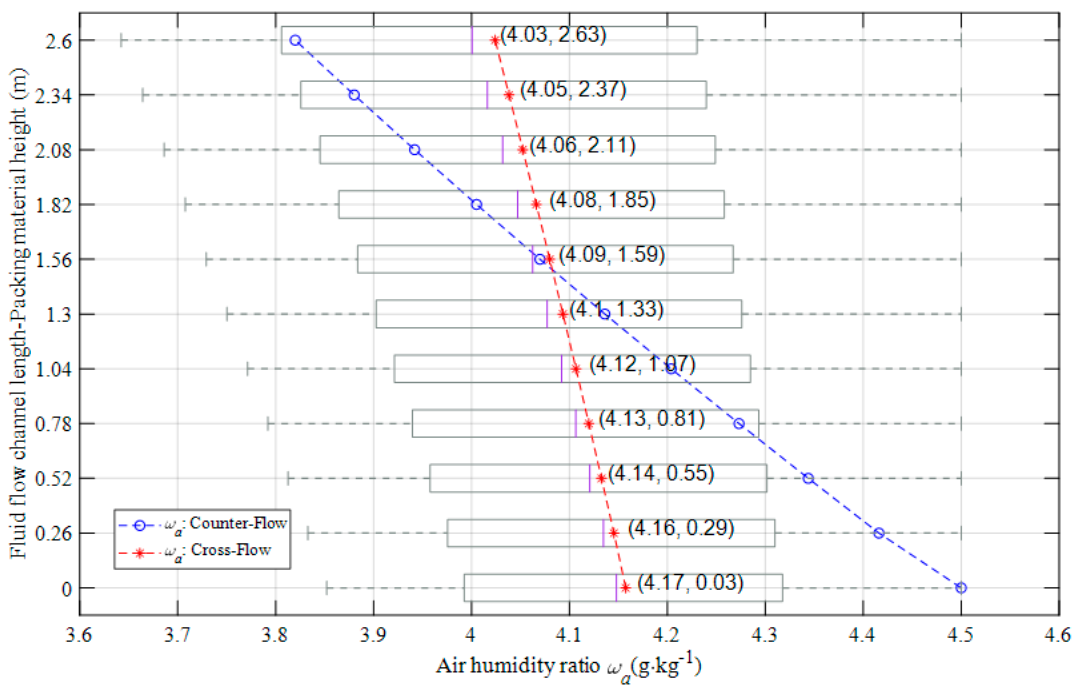
Figure 10. Variation of air humidity ratio within the fluid flow channel length.